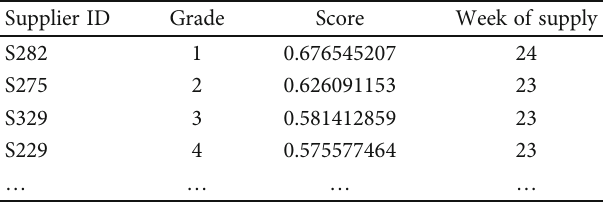
Table 2: The CRICTIC score of all